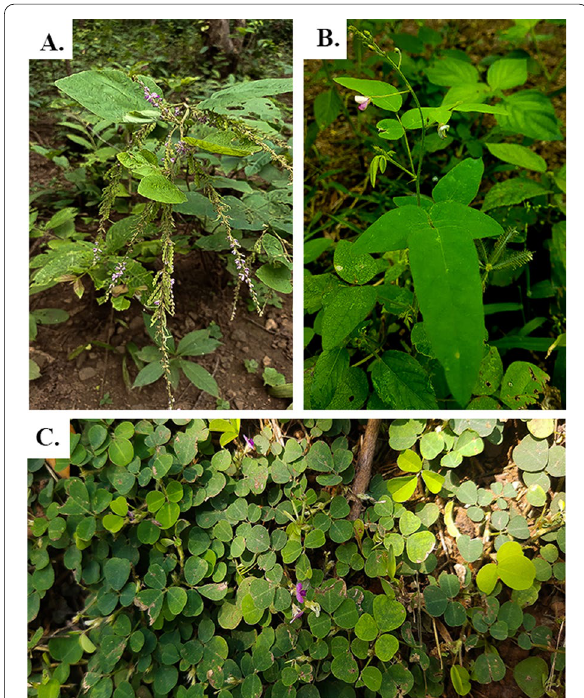
Fig. 3 Some original photographs taken during collection